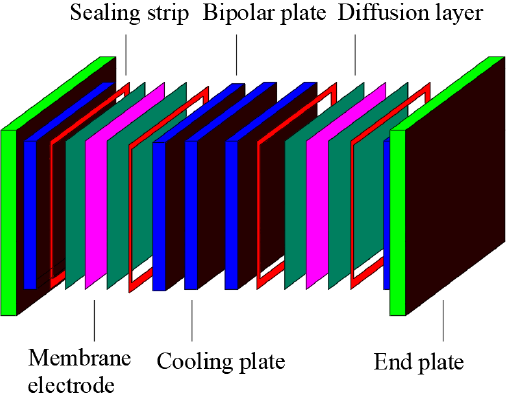
Figure 1. Schematic diagram of the structure of the proton exchange membrane fuel cell.